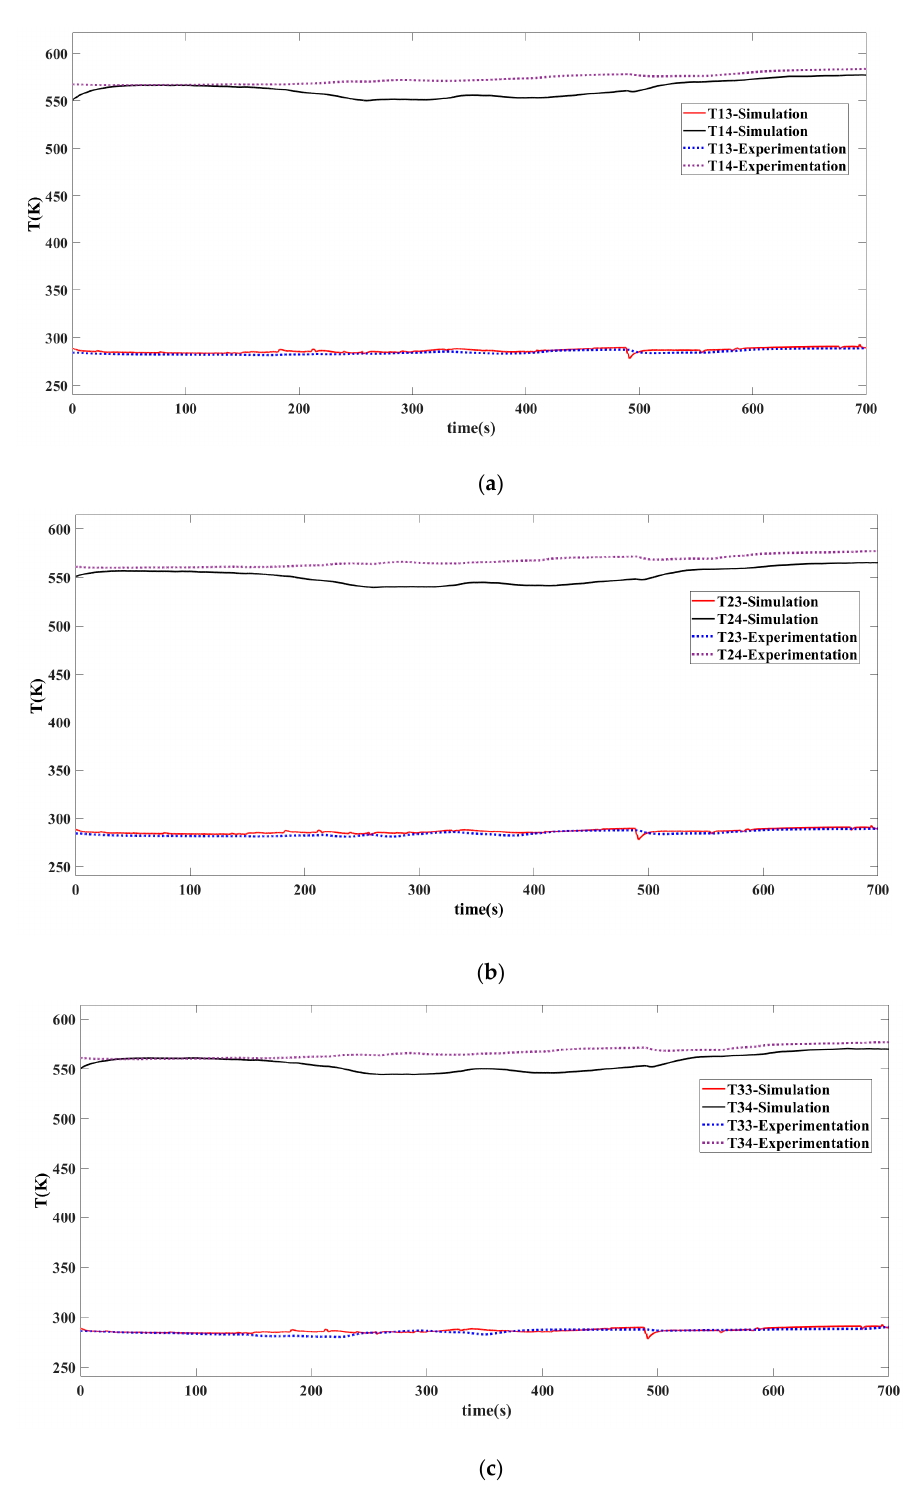
Figure 6. Comparison of simulation and experimental results on compressor temperature. ( a ) Re- sults of compression subsystem 1, ( b ) results of compression subsystem 2, ( c ) results of compression subsystem 3.